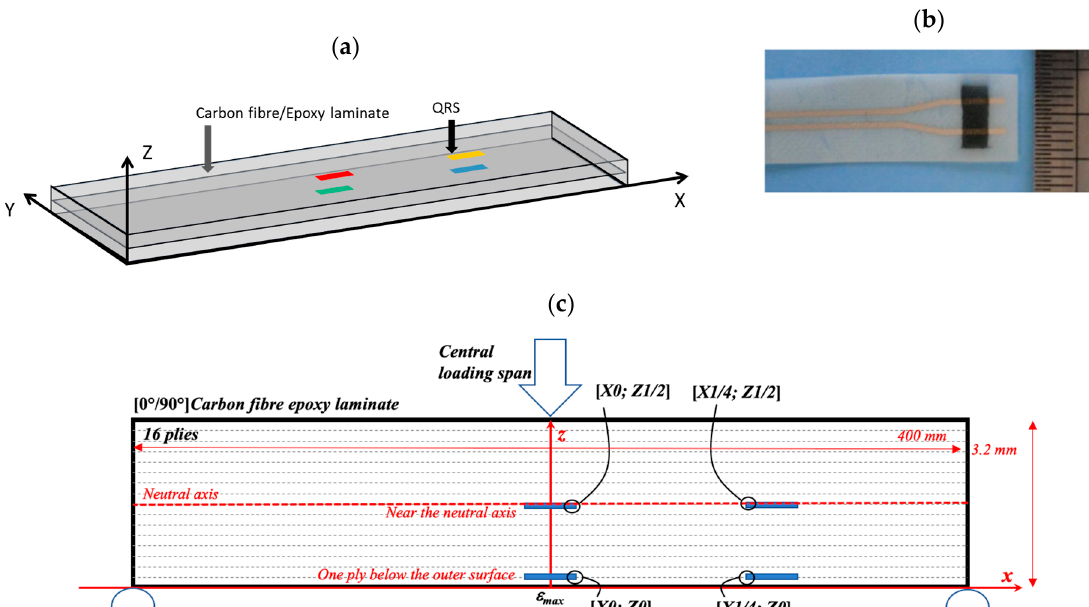
Figure 2. ( a ) Diagram of the CFRP specimen with embedded QRS below the surface and in the region of the neutral axis along with their name and position in the laminate. ( b ) Photography of a QRS, including the substrate (whitish area), the conductive silver-based tracks and the active CNT-filled QRS (dark area) ( c ) Representation of the CFRP specimen and the detailed location of the QRS during three-point bending experiments (QRS placed in the tension zone) .